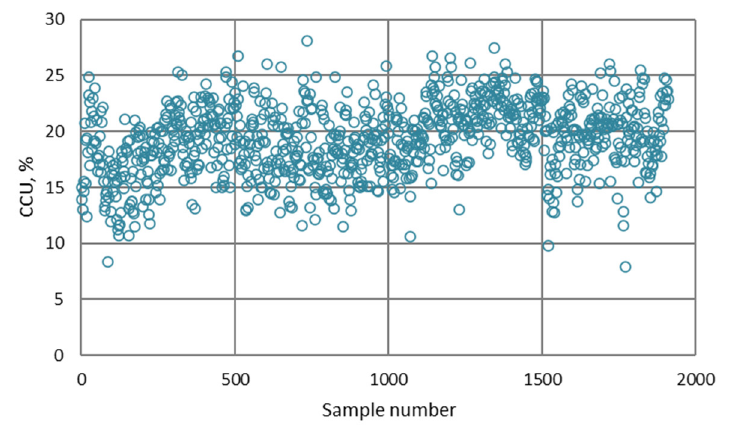
Figure A14. PMM model—training dataset for CCU output variable.